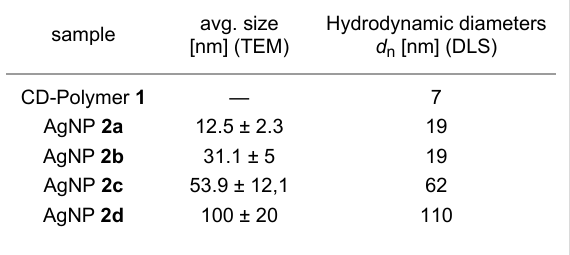
Table 1: Average particle size determined by TEM and DLS.